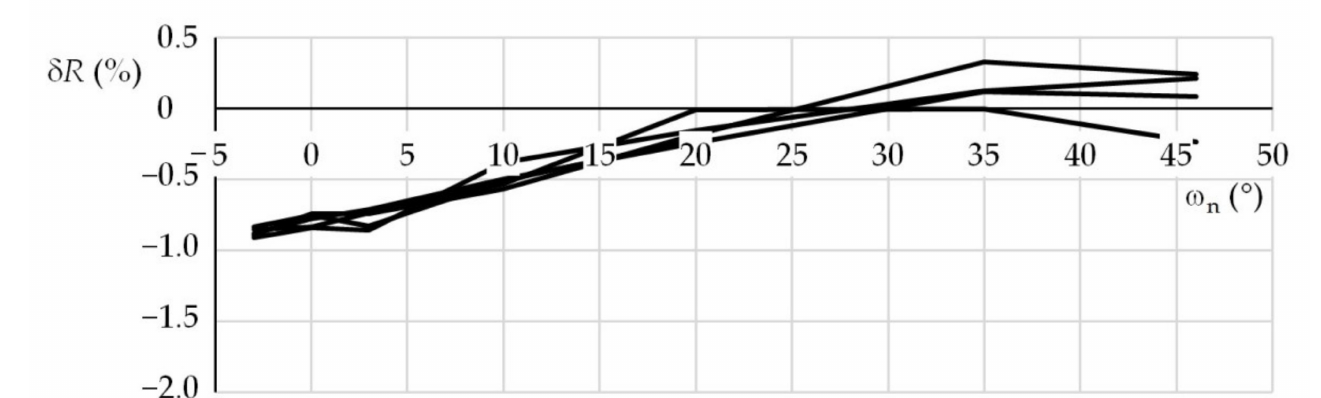
Figure 4. Beacon distance percentage errors; first test, ψ n = 20 ◦ .